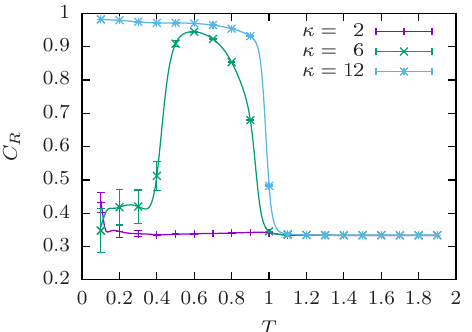
Figure 4. End-to-end correlation parameter C R for M = 4 semiflexible polymers of length N = 13 at the selected bending stiffness values. The aggregate morphology changes from uncorrelated ( κ = 2) over initially correlated ( κ = 6) to correlated ( κ = 12). For a full κ overview with exemplary conformations, see Figure